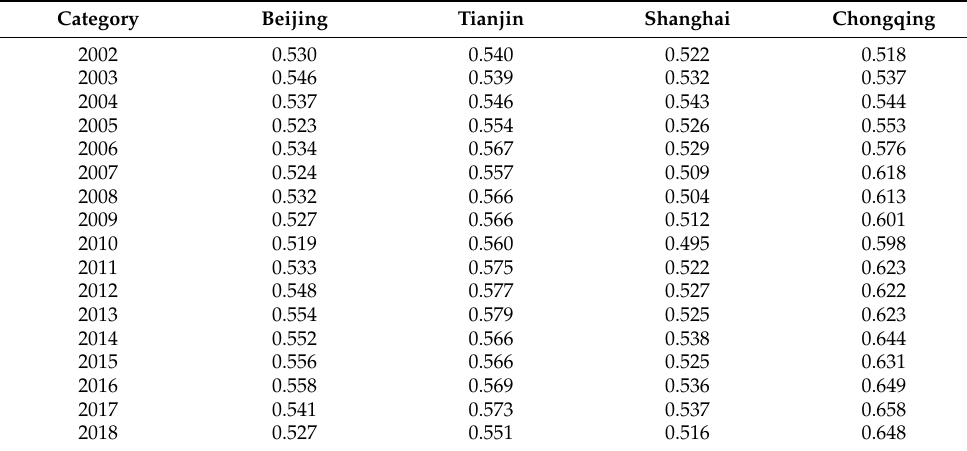
Table A3. Scores in state resilience levels from 2002 to 2018.